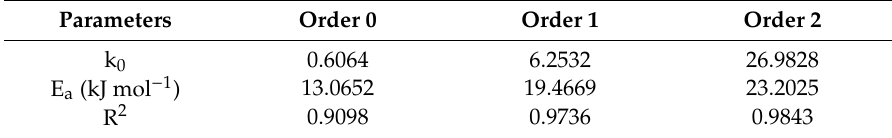
Table 3. Activation energy and pre-exponential factor for di ff erent temperatures.